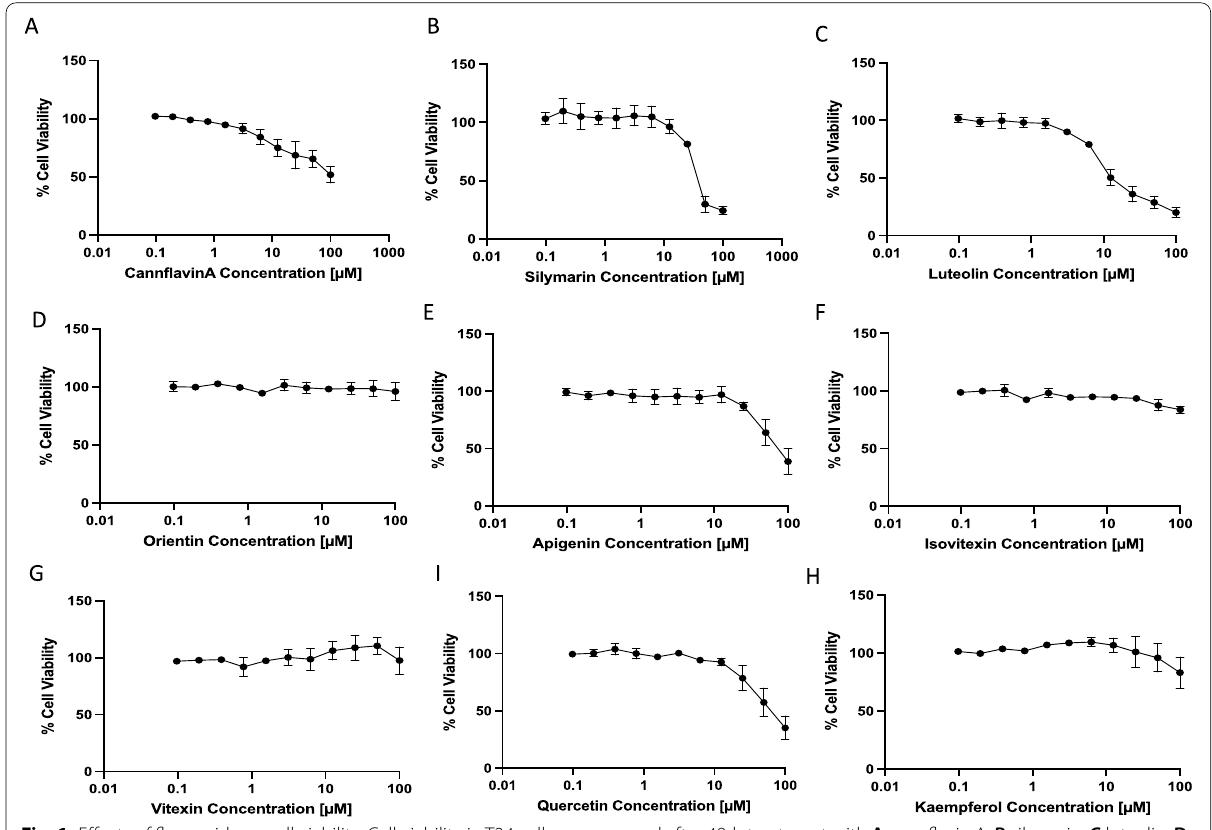
Fig. 1 Effects of flavonoids on cell viability. Cell viability in T24 cells was assessed after 48-h treatment with A cannflavin A, B silymarin, C luteolin, D orientin, E apigenin, F isovitexin, G vitexin, H kaempferol, and I quercetin. The results indicate that flavonoids from cannabis induce variable effects, dependent on both the individual flavonoid and their concentrations. Results are means